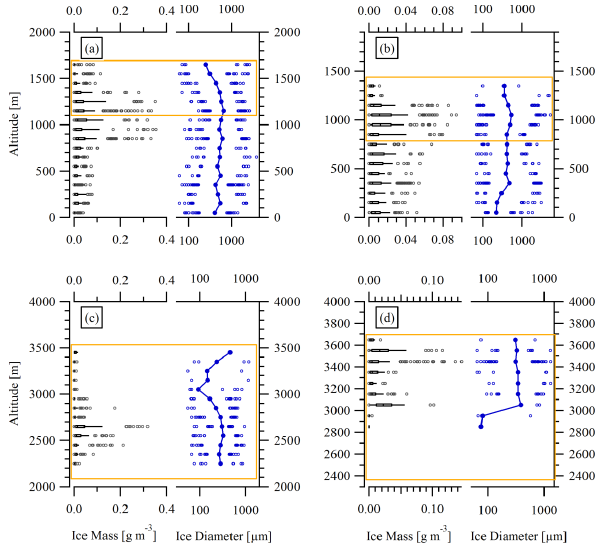
Figure 12. Box and whisker plots with 50th, 25th, 75th percentiles, whiskers to 10 and 90% and outliers between 95 and 100% as a function of altitude for ice mass (black) and median ice crystal di- ameter with outliers between 95 and 100% (blue) ( (a) – (d) and al- titude averages as in Fig. 10). The box in yellow provides an indi- cation of the full extent of cloud layers investigated. (a) – (d) are for spring case 1, spring case 2, summer case 1 and summer case 2,